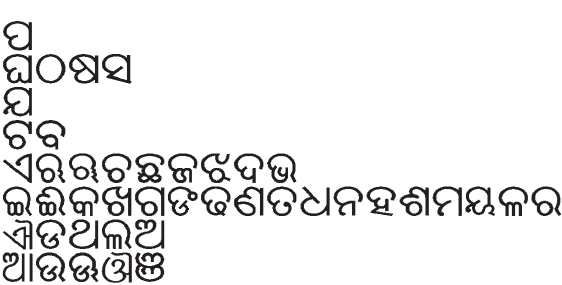
Figure 12. Clusters by string